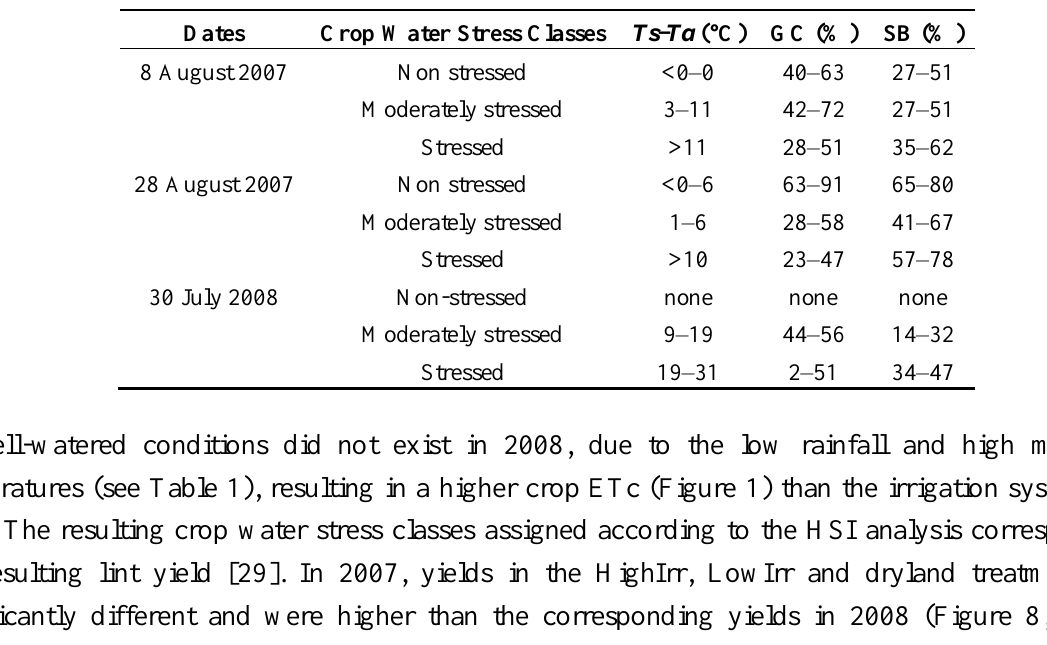
Table 2. Ts-Ta , GC and SB ranges corresponding to crop water stress